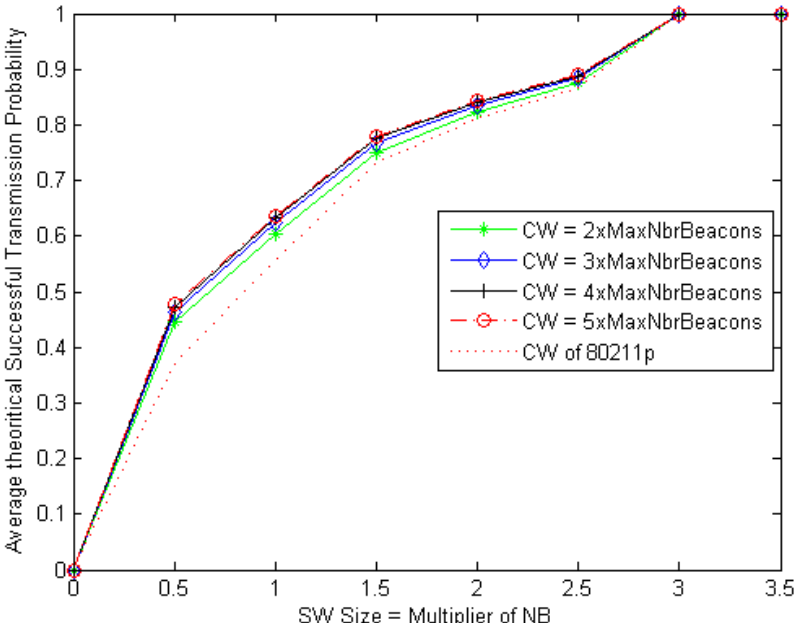
Figure 7. The impact of the SW and CW size on the average successful transmission probability for the CSSA MAC